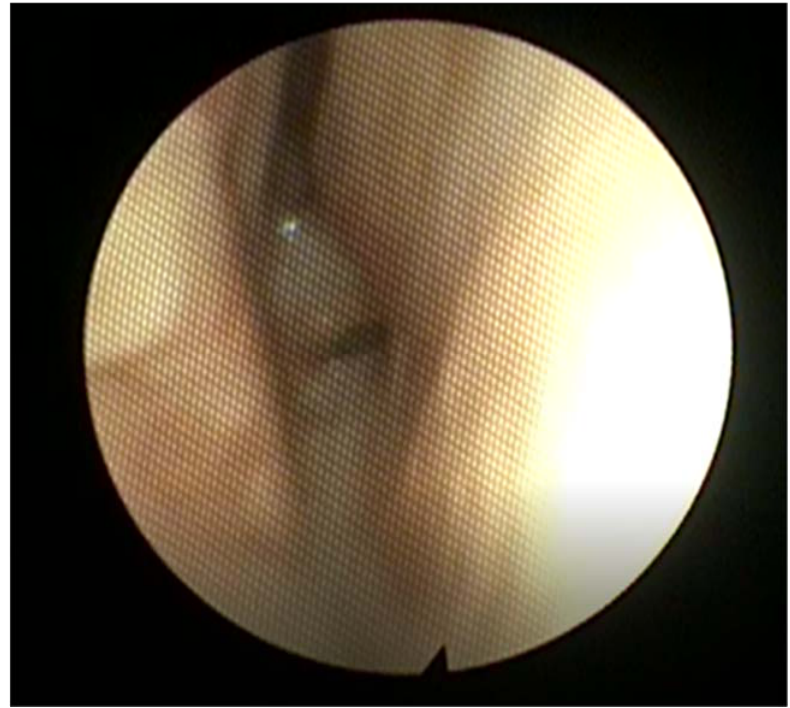
Figure 10. Posterior nasal endoscopy in a patient with severe choanal stenosis. Note the narrow choanal opening, with the septum to the right in this image.